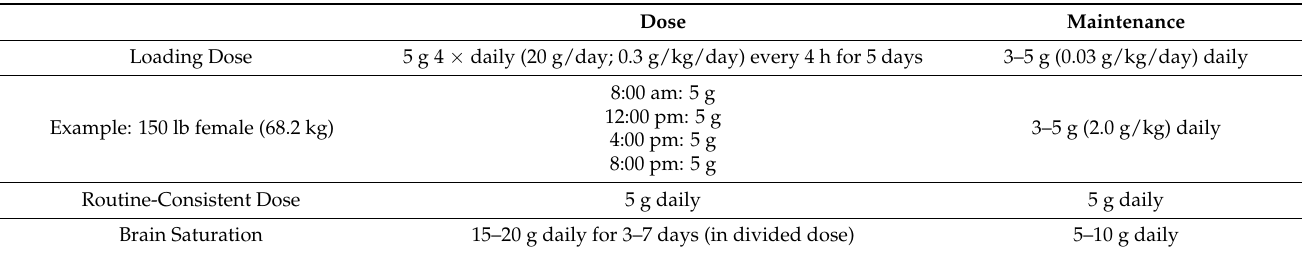
Table 1. Dosing guidelines for creatine supplementation in females [2,67,84,101]. Dose Maintenance Loading